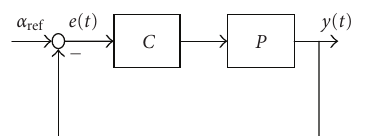
Figure 9: Closed-loop control system for